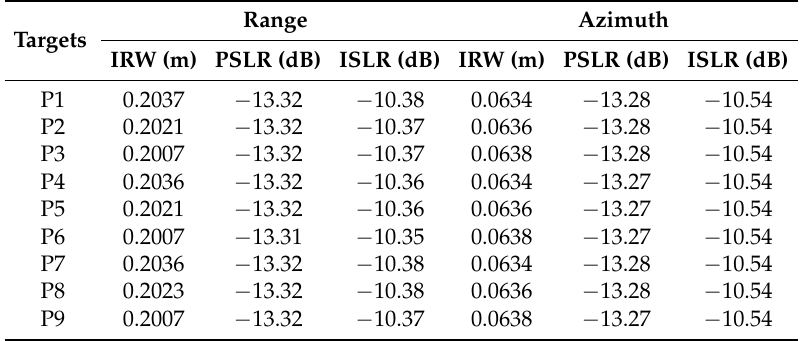
Table 4. Evaluation of Imaging Quality in Simulation Experiment by Using the Proposed